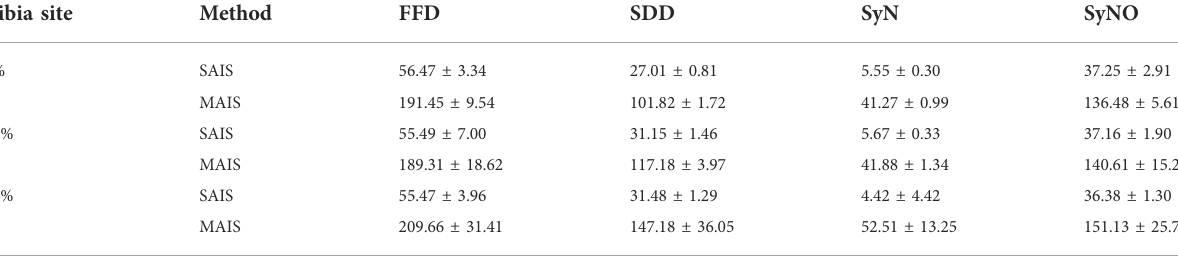
TABLE 14 Mean ± standard deviation (in seconds) of the execution times of SAIS and MAIS with respect to nonlinear registration